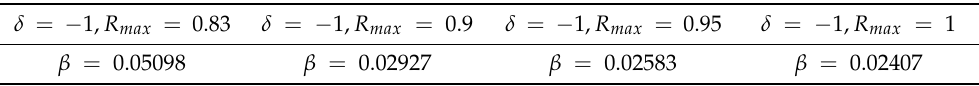
Table 8. Coefficient stability